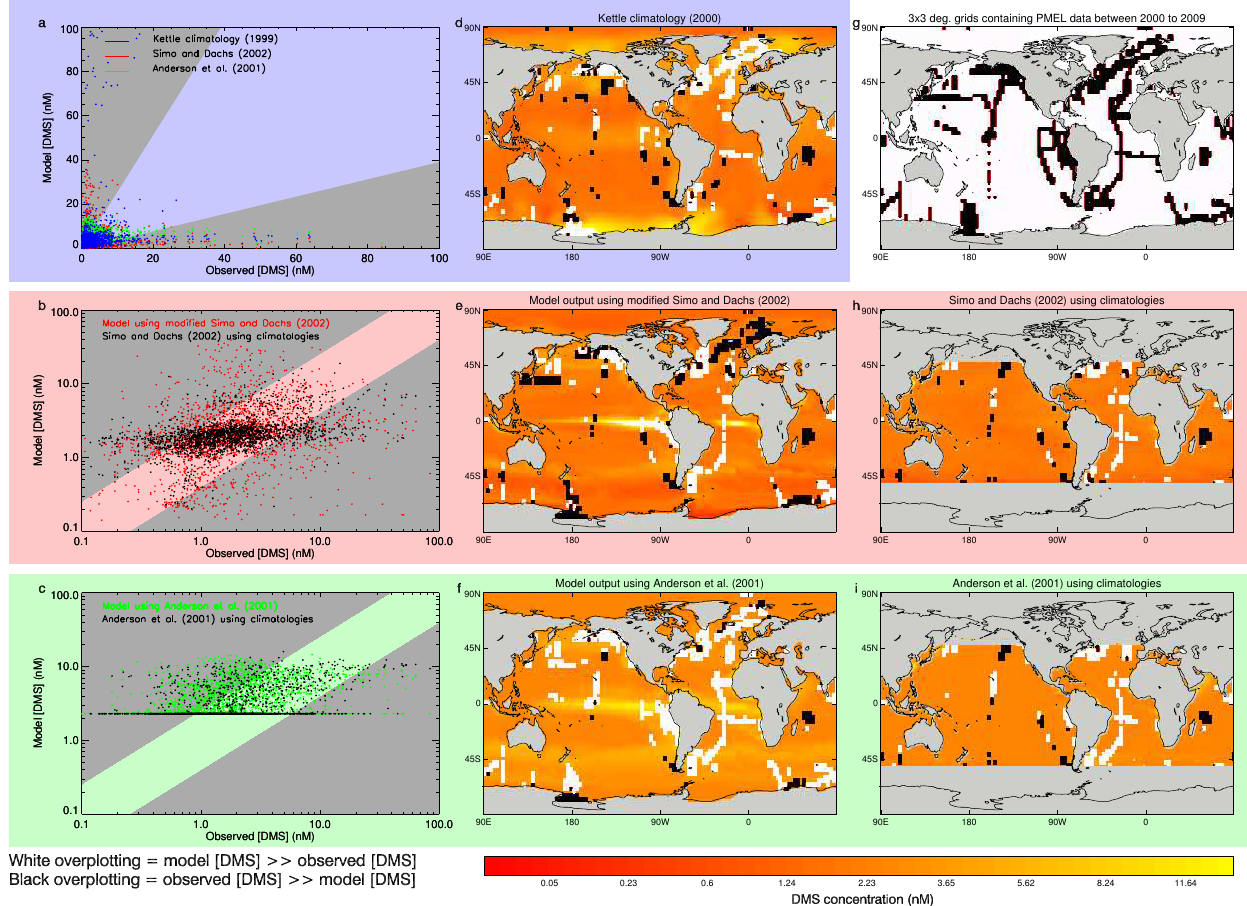
Fig. 2. Assessment of model and climatology success at predicting observed seawater [DMS] in a spatial context. (a–c) Model and climatol- ogy [DMS] predicted in monthly one degree grid-squares corresponding to (and plotted against) average observed values calculated for the same grid square in the same calendar month. Greyed areas represent regions where predicted values for a specific month are greater than three standard deviations above observations for that month (see main text for details), or where observations are greater than three standard deviations above predictions. Note that the axis limits artificially hide the extreme values, but were considered to best present the majority of the data. (d–f) Annually averaged present day fields for surface ocean [DMS] as predicted in the Kettle climatology, using the Simo (2002) scheme and the Anderson (2001) scheme respectively (red-yellow shading). Plotted on-top of the annual average global fields are the loca- tions of data, corresponding to those points highlighted in the grey regions of parts a b and c, i.e. where predictions were more than three standard deviations above observations (white over-plotting) or where observations were more than three standard deviations above predic- tions (black over-plotting). (g) Plot showing the geographical location of all observations made between 2000 and 2009, and inputted into the PMEL database (http://saga.pmel.noaa.gov/dms/) by the start of January 2009. ( h and i ) As for “e” and “f” but where [DMS] has been calculated using climatological fields rather than model fields, using the Simo (2002) and Anderson (2001) parameterisations respectively. Note that all over-plotting has been done using a 3 × 3 degree grid (rather than the 1 × 1 degree grid used for all of the calculations) to make the results clearer to the